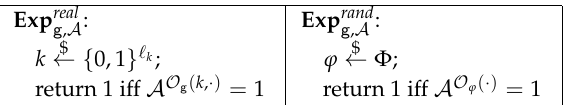
Figure 1. Experiments for a pseudo-random